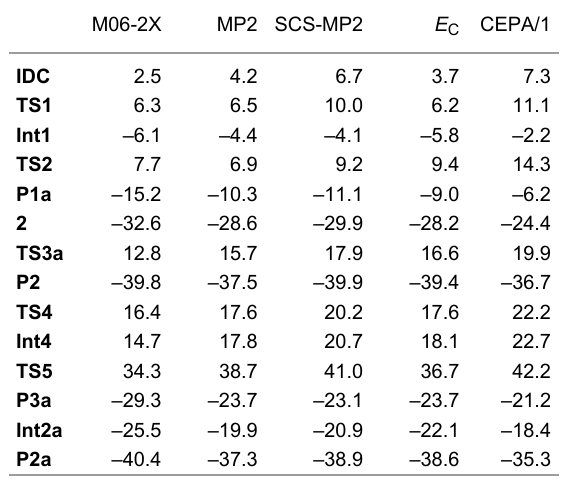
Table 1: Relative Gibbs free energies for all stationary points consid- ered a